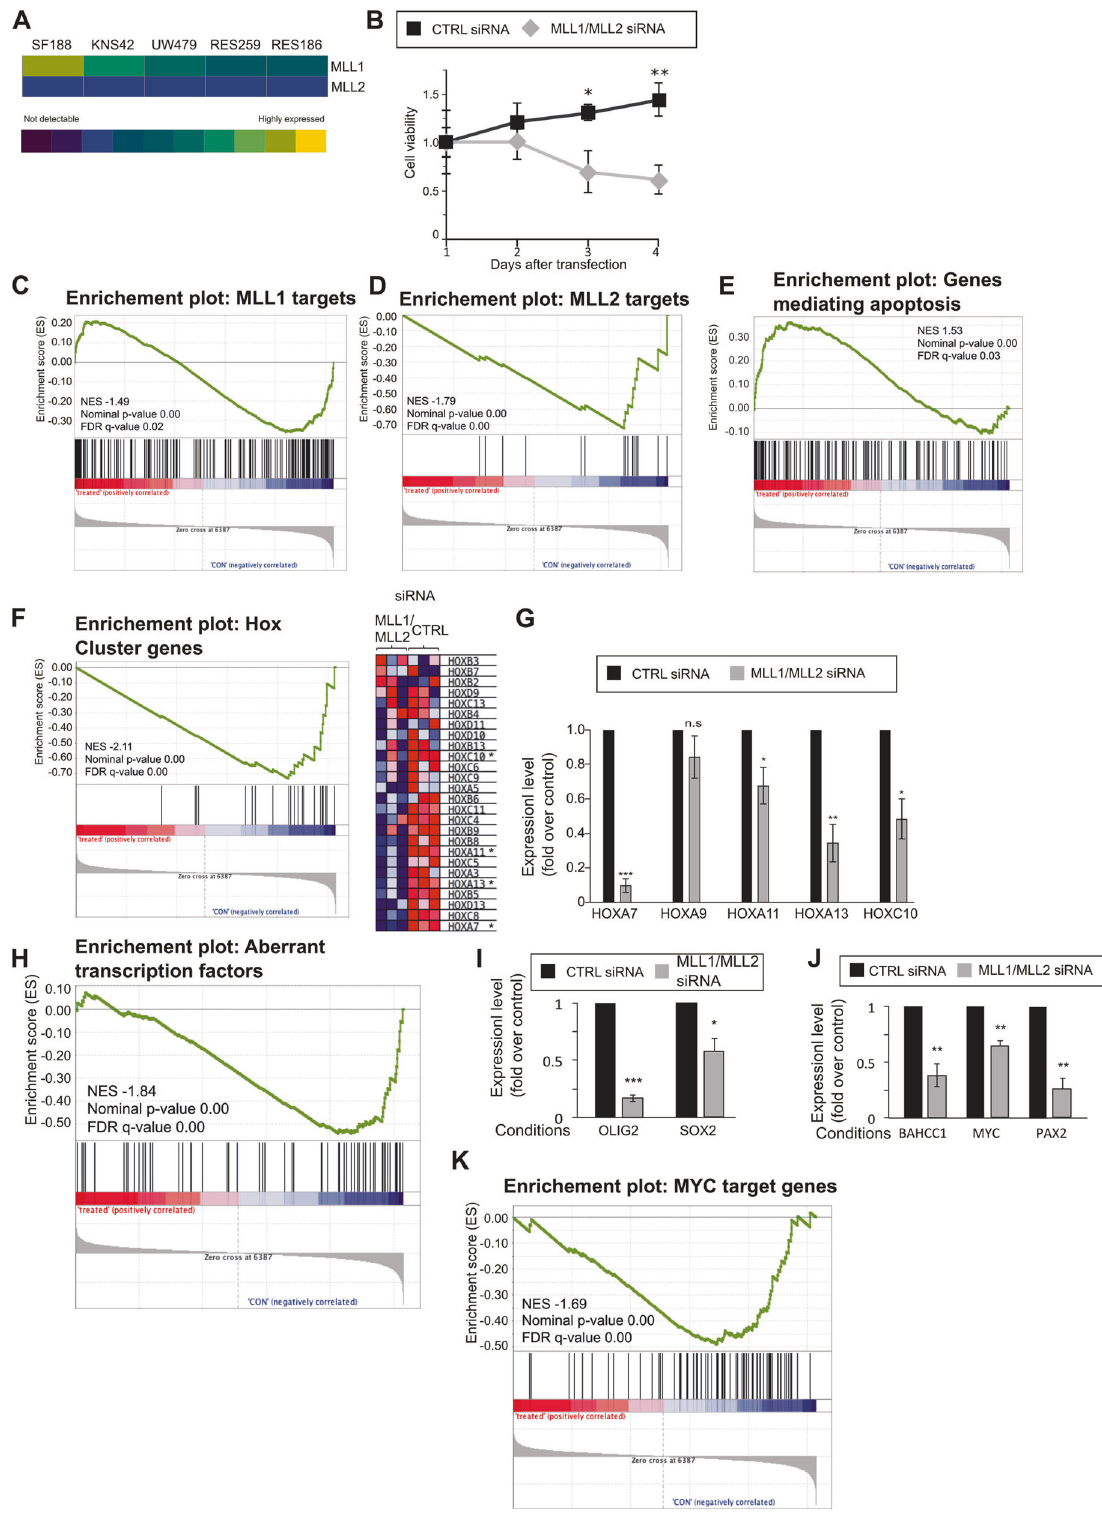
cells (Fig. 1A). We con fi rmed this data by western blot analysis (Supplementary Fig. 1b, MLL2 was not detectable by western blot analysis in SF188 cells with different commercially available antibodies). To explore the functional roles of MLL proteins, we downregulated MLL1 and MLL2 in SF188 cells using a pool